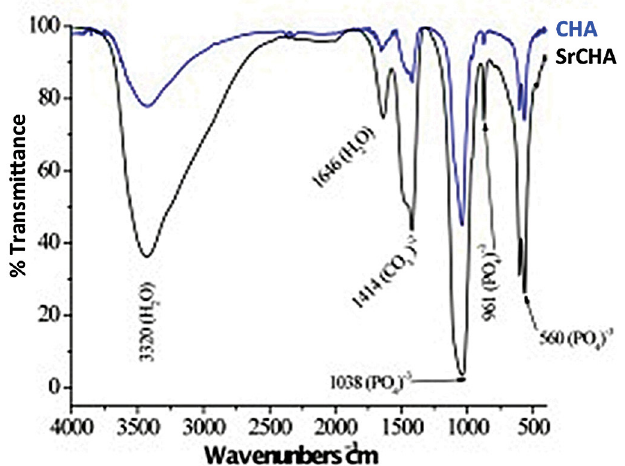
Figure 2- Infrared Fourier transform spectrum of CHA and SrCHA. We observed major bands regarding phosphate and carbonate groups, a characteristic of carbonated hydroxyapatite. Presence of water bands, indicating the material is not ceramic (regions 867, 868, 1415, 1425, and 1482 cm −1